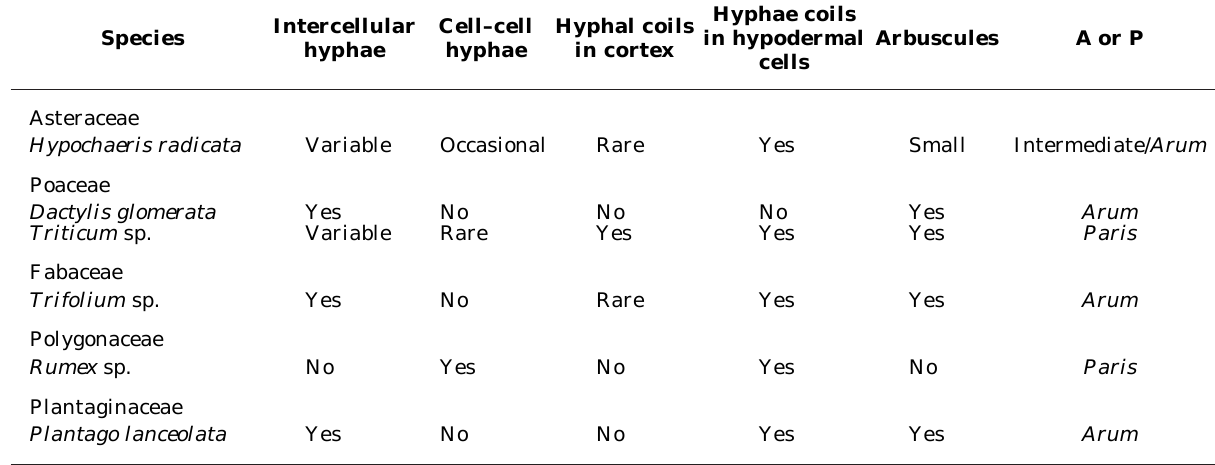
Table 4. Incidence of Arum (A) and Paris (P)-type mycorrhizas in different species in the Waite Permanent Rotation